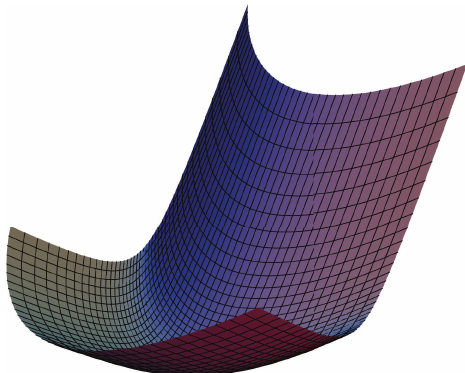
Figure 6: A surface with constant mean curvature obtained by an isotropic rotation.